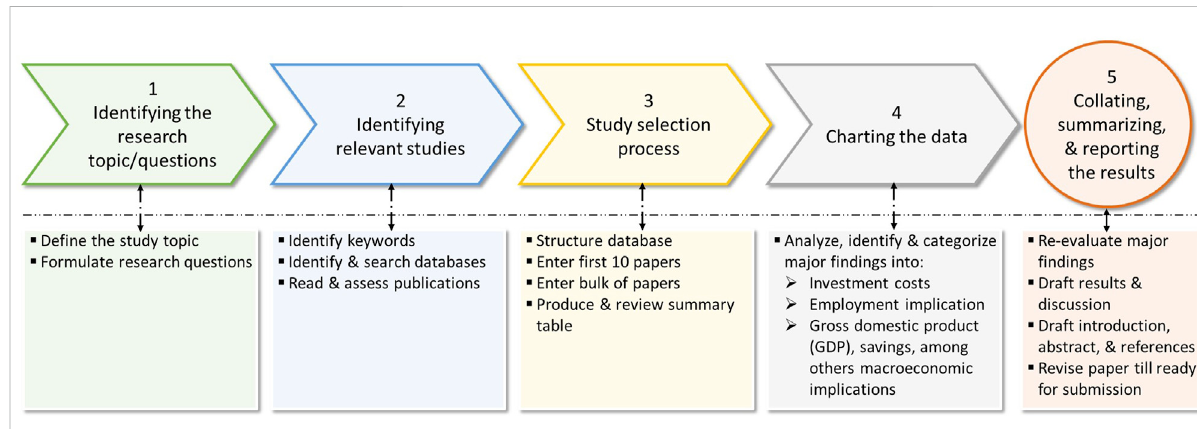
FIGURE 1 The systematic review methodology used in this study. Source: Authors ’ diagram.